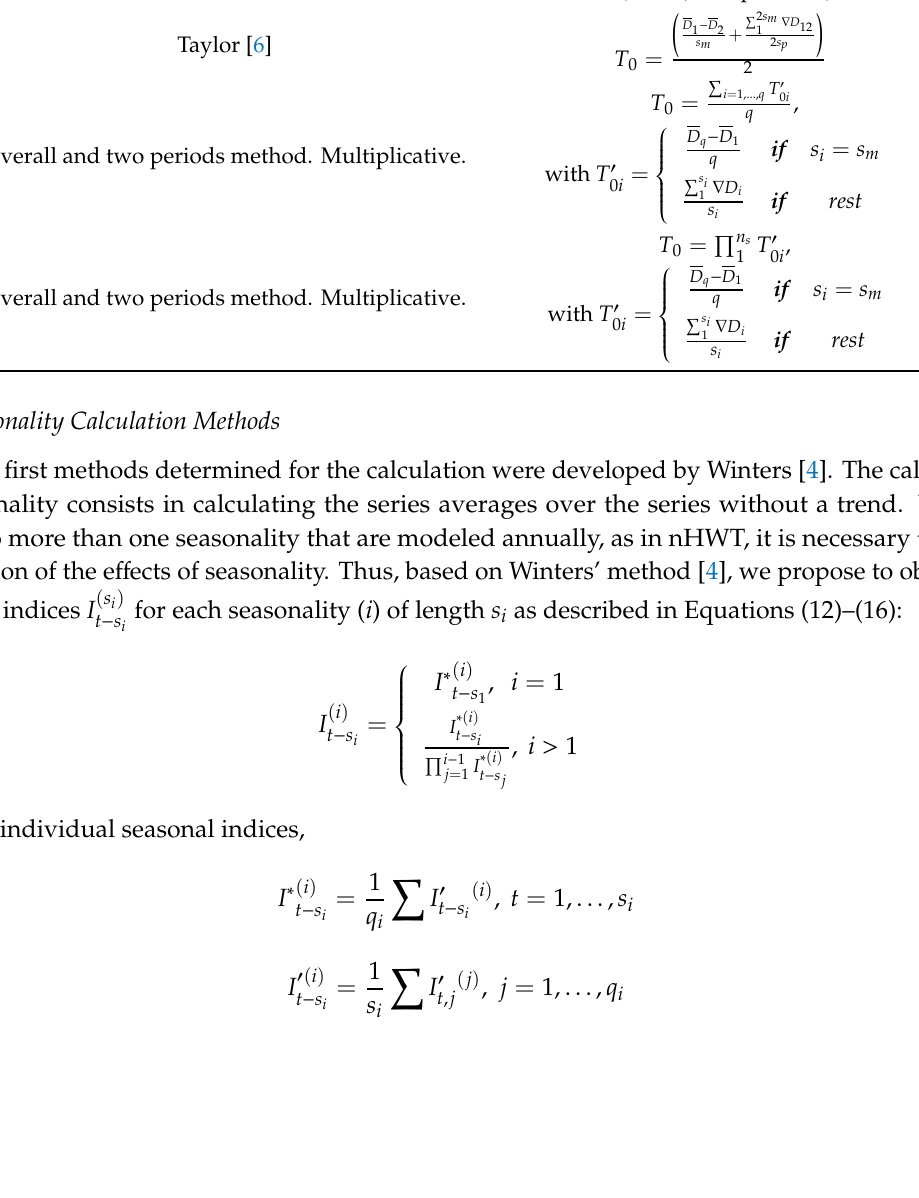
T 0 = 0 (additive) T 0 = 1 (multiplicative) (cid:32) (cid:33) (cid:80) 2 sm ∇ D 12 D 1 − D 2 1 + sm 2 sp T 0 = 2 T 0 =